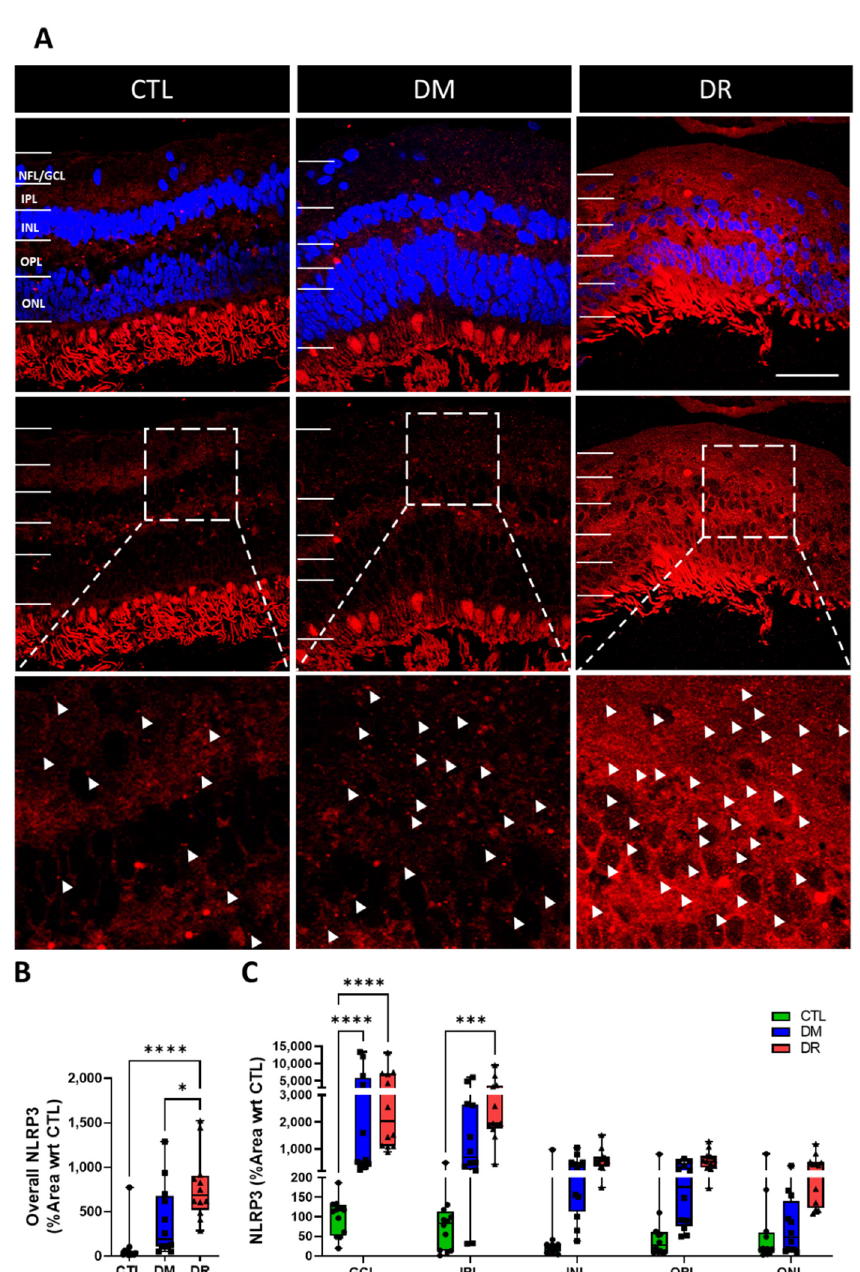
Figure 6. NLRP3 is upregulated in DR compared to CTL and DM. ( A ) Immunohistochemical labelling of NLRP3 (red) showed low levels of NLRP3 in CTL and DM but high levels in DR. ( B ) Quantification of levels in the entire retina showed NLRP3 expression was significantly higher in DR compared to CTL ( p ≤ 0.0001) and DM ( p ≤ 0.05). ( C ) Quantification by each retinal layer showed NLRP3 expression in the GCL was significantly higher in DM ( p ≤ 0.0001) and DR ( p ≤ 0.0001) compared to CTL. Moreover, NLRP3 expression in the IPL was significantly higher in DR compared to CTL ( p ≤ 0.001). Minimal levels of NLRP3 were expressed in all groups in the INL, OPL and ONL. Inserts of immunohistochemical images are presented in the bottom row at 3 × magnification of the middle row. Scale bar = 50 µ m. Statistical analysis was carried out using one-way ANOVA for overall expression in the entire retina and two-way ANOVA for expression in each retinal layer. * p ≤ 0.05; *** p ≤ 0.001; **** p ≤ 0.0001. Data point of each patient in CTL, DM and DR are marked as circle, square and triangle,